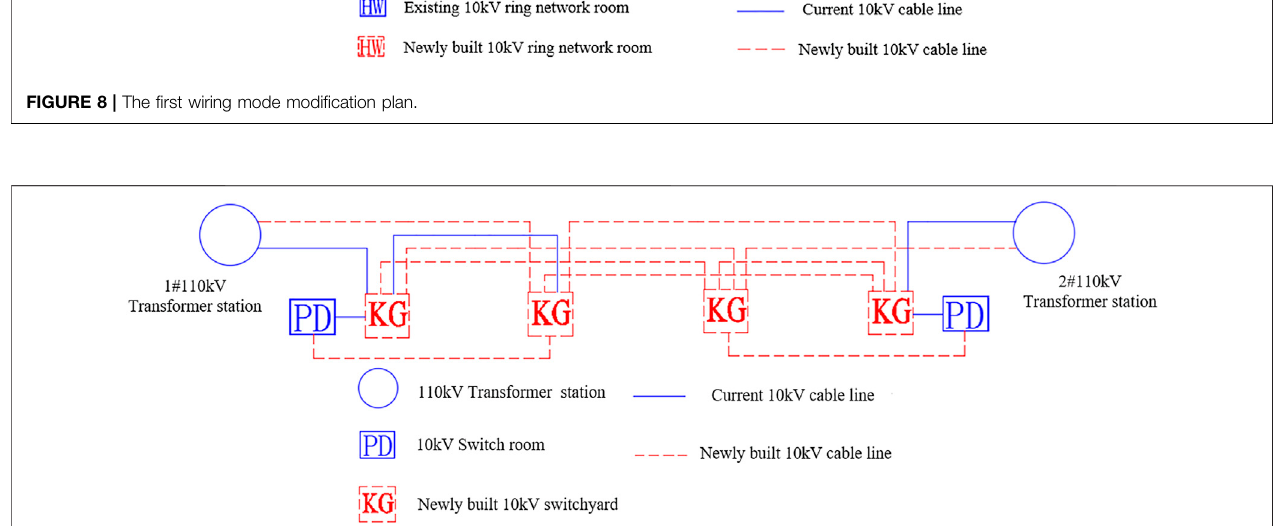
FIGURE 9 | The second wiring mode modi fi cation plan.